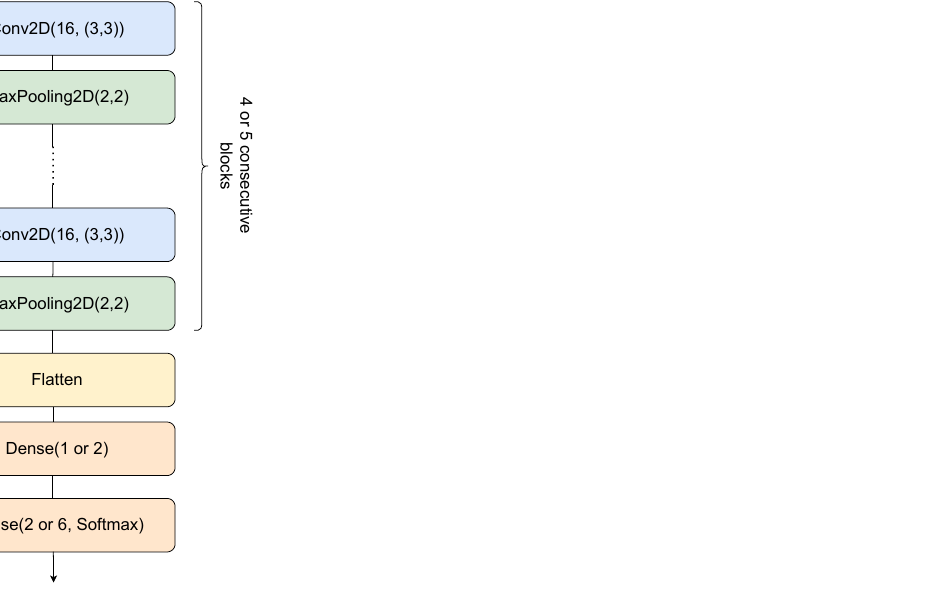
Figure 4. A general view of the neural network architectures we employ for binary and multi-class